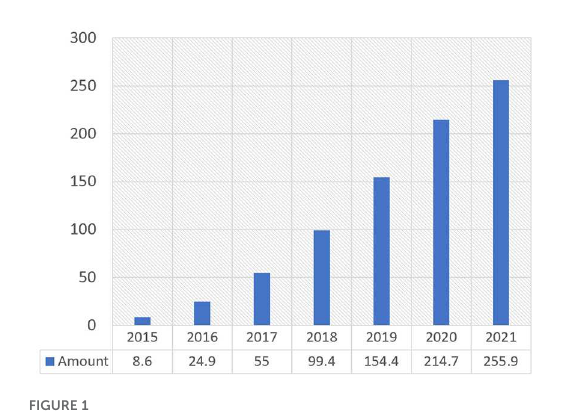
FIGURE1 Mobile payment transactions in Asia and the Pacific from 2015 to 2021 The United States billion dollars. Source: The authors’ compilation based on McKinsey (2021) available at the following link: https://www.mckinsey.com/~/media/mckinsey/industries/ financial%20services/our%20insights/the%202021%20mckinsey